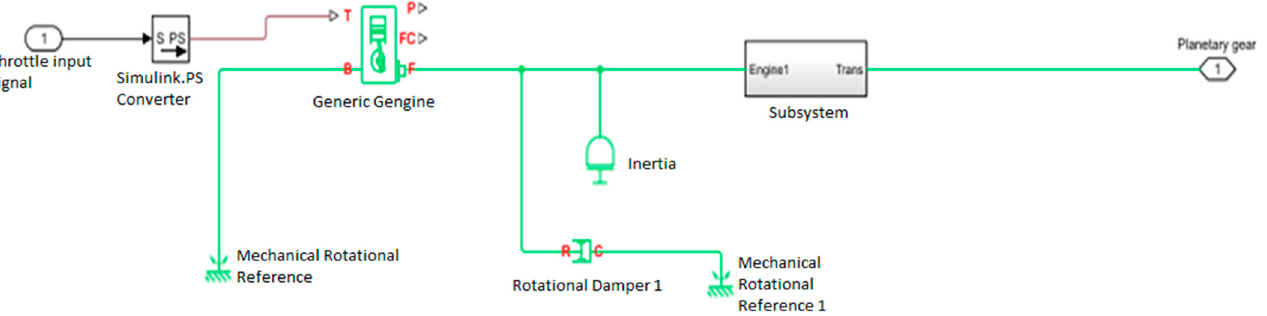
Figure 9. ICE model in Simulink.